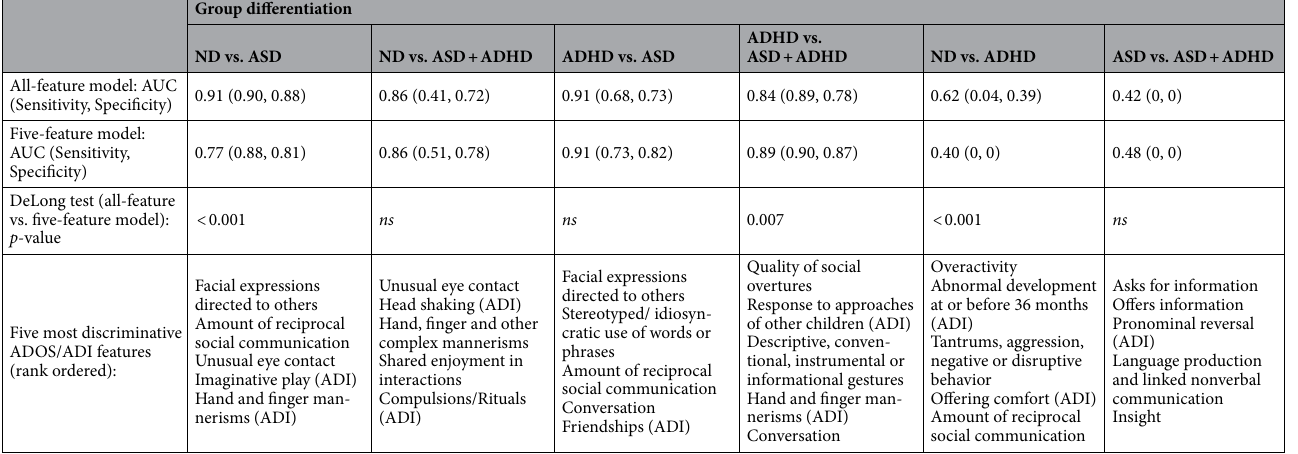
Table 2. Performance of the SVM machine learning algorithm in discriminating between the different group constellations. Additionally, a test with a sensitivity (i.e., positive test result in presence of the condition) and specificity (i.e., negative test result in absence of the condition) of around 75% to 90% can be considered to have reasonable to good diagnostic performance. ND no psychiatric diagnosis, ASD autism spectrum disorder, ADHD attention-deficit/hyperactivity disorder, ns not significant; AUC area under the curve: AUC < 0.7 (poor discrimination), 0.7 ≤ AUC < 0.8 (acceptable discrimination), 0.8 ≤ AUC < 0.9 (excellent discrimination), AUC ≥ 0.9 (outstanding discrimination) according to Hosmer et al. . 44 .